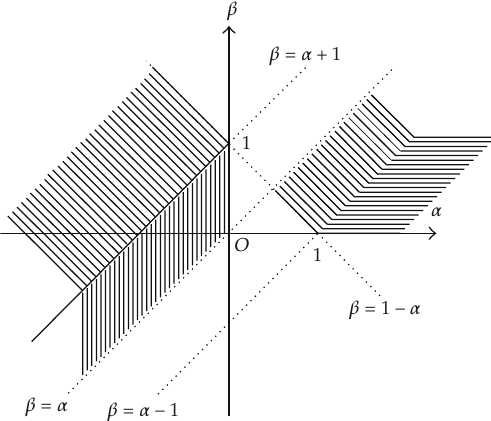
Figure 3: (cid:3) α,β (cid:5) -domain where q α,β (cid:3) t (cid:5) is increasing on (cid:3) 0 , ∞ (cid:5) .